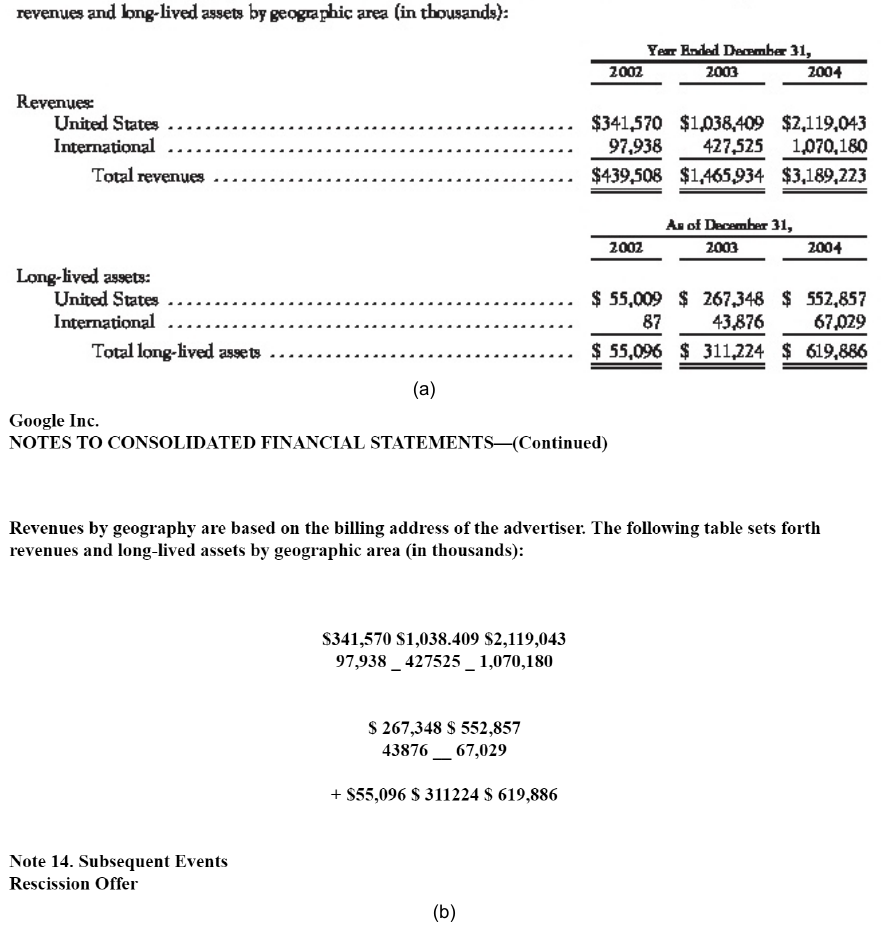
Figure 1. This figure shows the importance of detecting graphical page objects: ( a ) shows a document image from the IIIT-AR-13k [9] dataset. In contrast, ( b ) shows the result of Tesseract-OCR [10] on the document image. Note that the naive application of Tesseract-OCR on the document image leads to poor extraction of